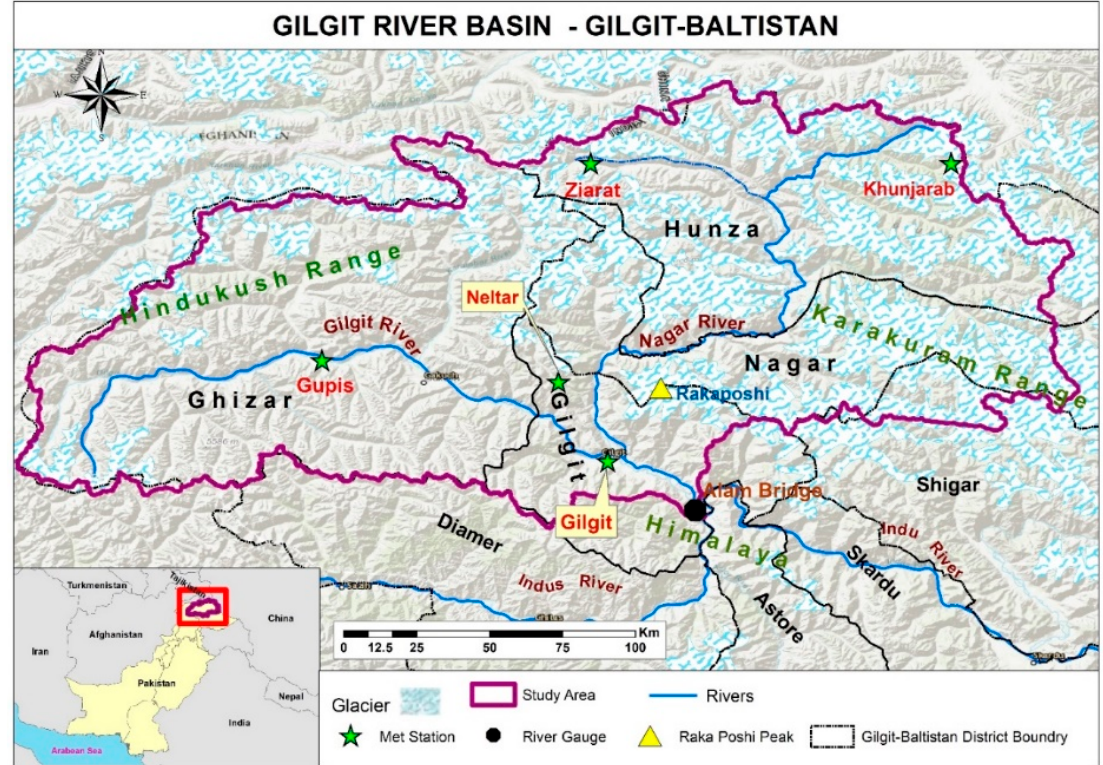
Figure 1. Study area in northern Pakistan.